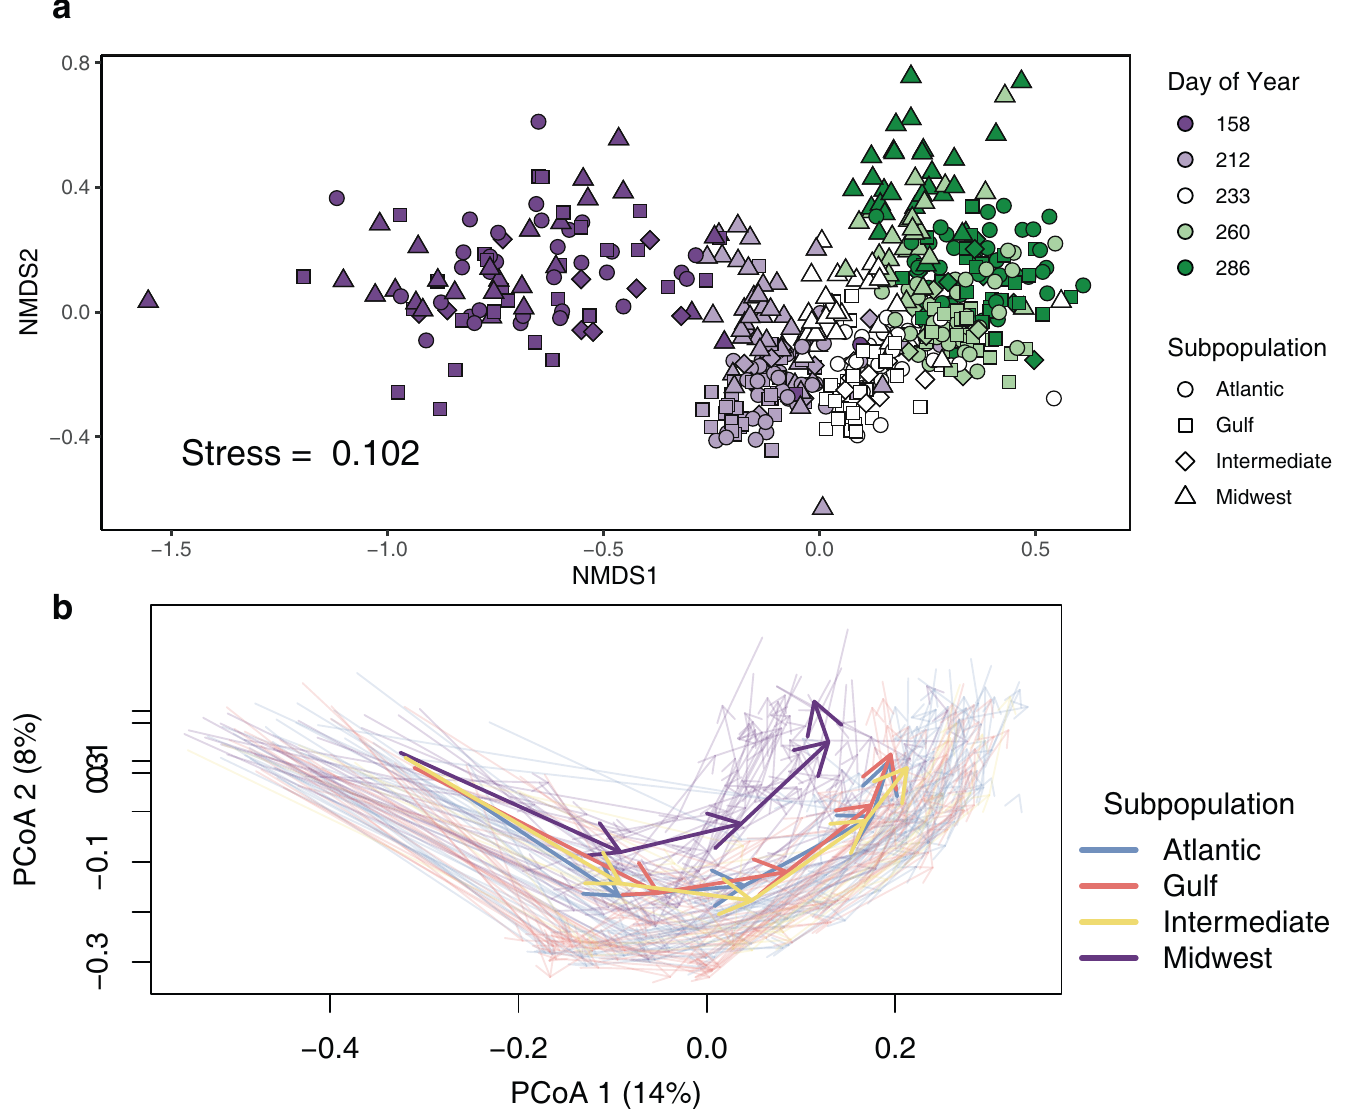
Fig 1. Structural and successional change in the leaf phyllosphere community shown by 2 methods. Each point represents an individual plant sampled from the experimental plot at KBS, Michigan. (A) NMDS. Dates are shown as DOY. Points are colored by DOY, and switchgrass subpopulations as shapes. (B) Trajectory plots of principal coordinates of community distances. Transparent arrows represent individual switchgrass genotypes sampled over the 5 dates shown in (A), and colors show genetic subpopulations. Solid colored arrows show mean subpopulation trajectories. Data underlying this figure can be found in S1 Data. D AU : AbbreviationlistshavebeencompiledforthoseusedthroughoutFigs 1 (cid:0) 5 : Pleaseverifythatallentriesarecorrect : OY, day of year; KBS, Kellogg Biological Station; NMDS, nonmetric multidimensional